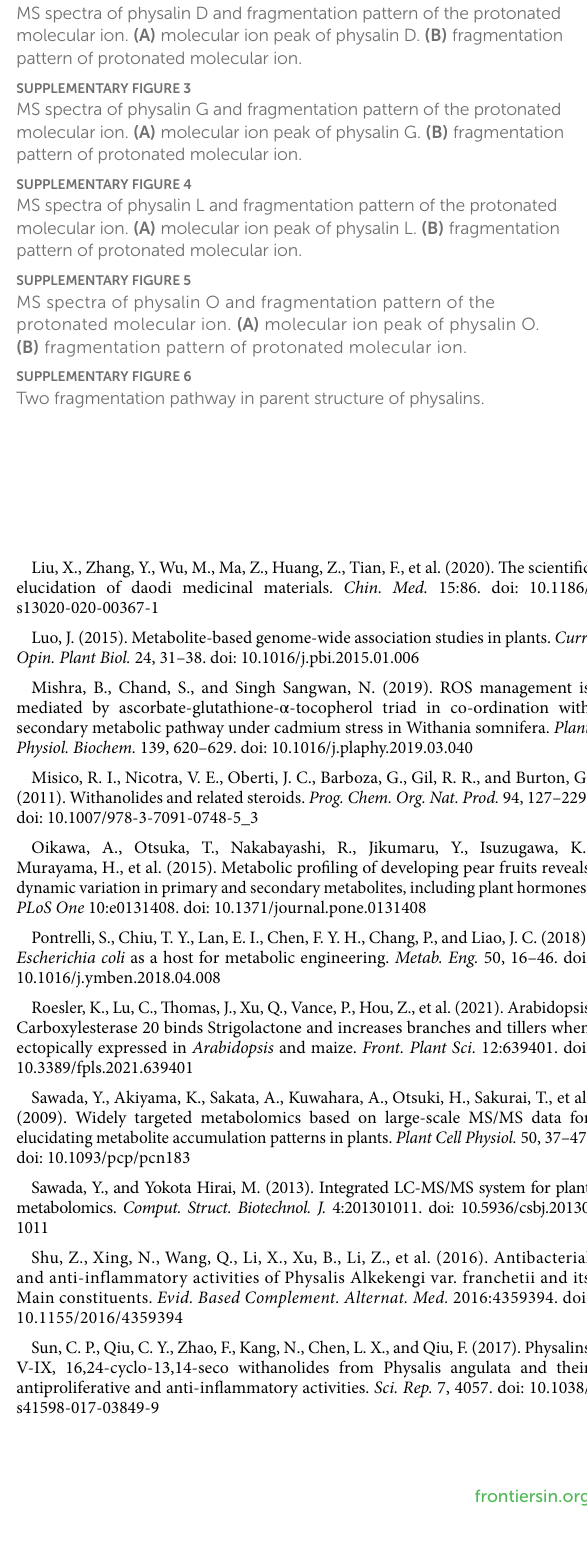
SUPPLEMENTARY FIGURE 2 MS spectra of physalin D and fragmentation pattern of the protonated